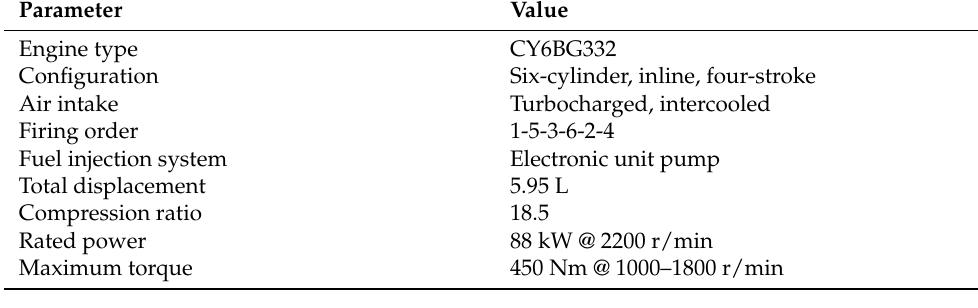
Table 1. Engine specifications.